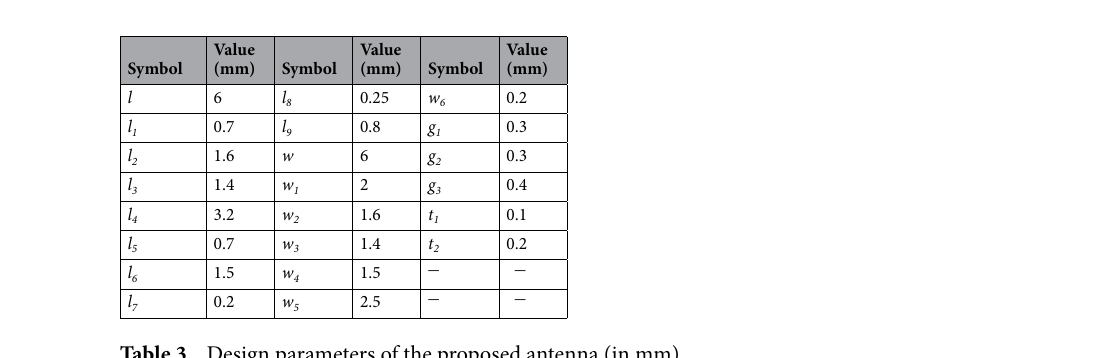
Figure 9. Geometry of the proposed dual-band antenna for the leadless cardiac pacemaker. ( a ) Front view (Loop patch) ( b ) Side view ( c ) Exploded view.